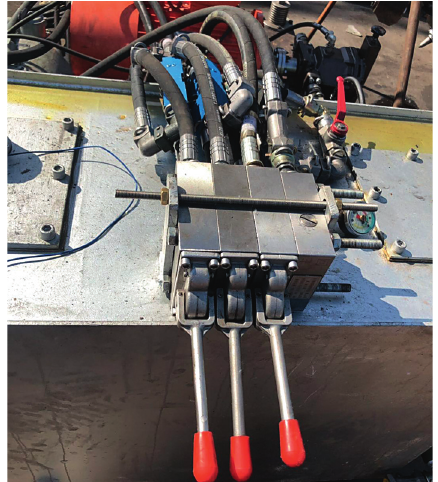
Figure 16: Hydraulic control